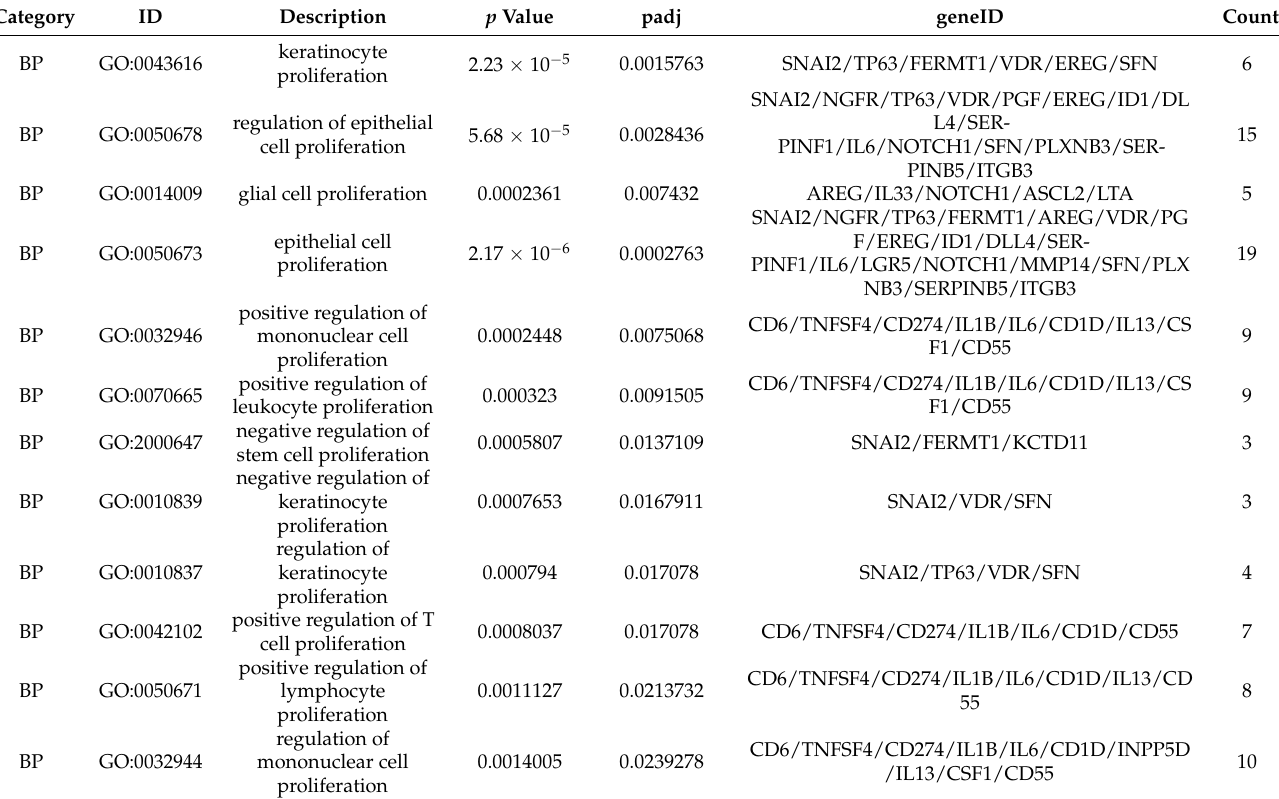
Table 3. The GO gene sets involving cell proliferation and focal